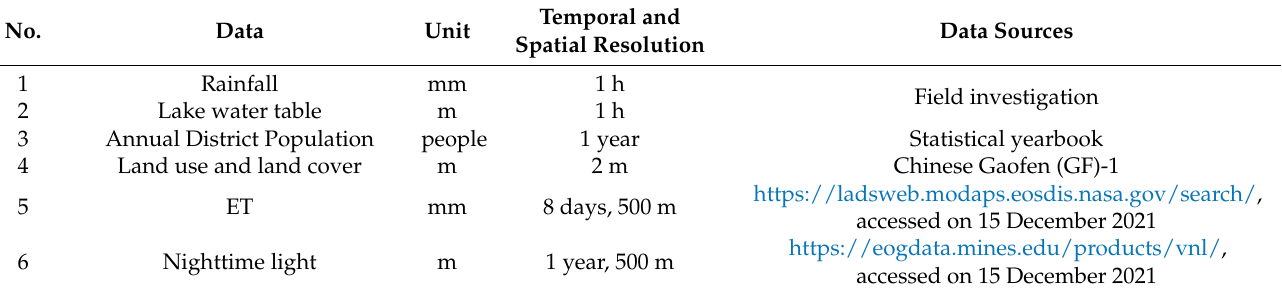
Table 2. Statistics of the related data